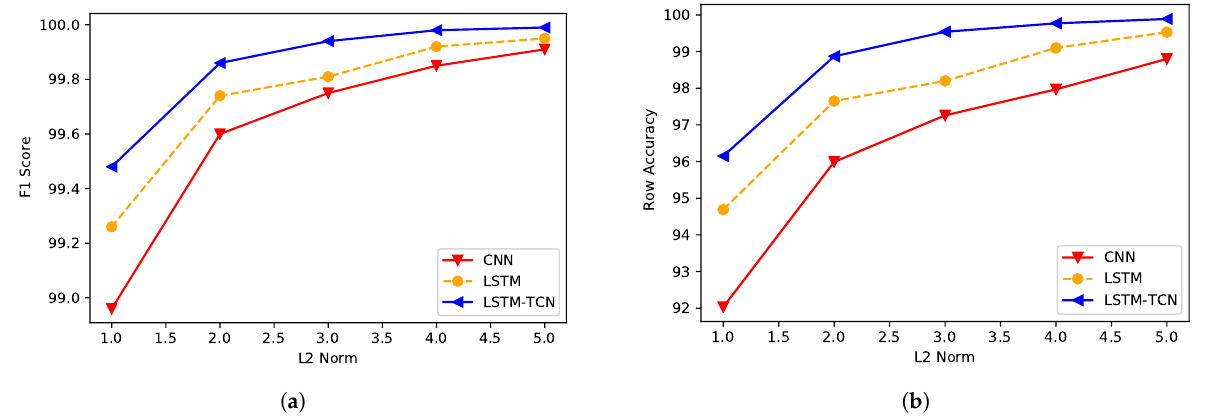
Figure 5. F1-score and RACC comparison in the IEEE 14-bus system: ( a ) F1-score comparison versus the L 2 -norm of the injection attack; ( b ) RACC comparison versus L 2 -norm of the injection attack.